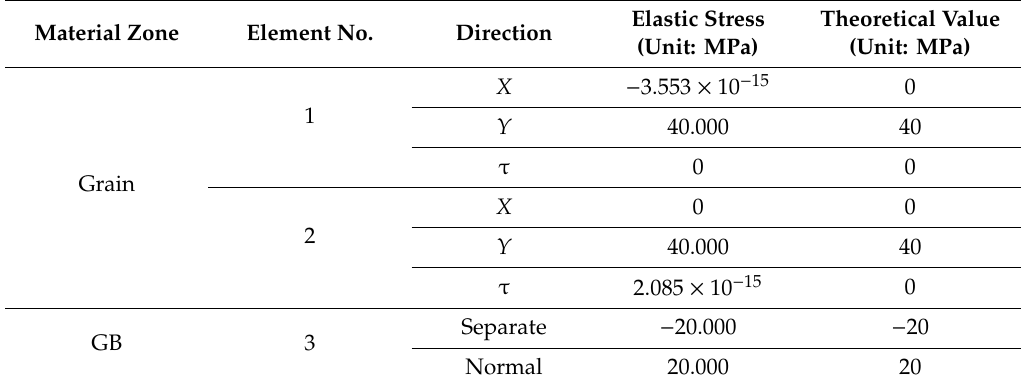
Table 4. Elastic stress for each element.